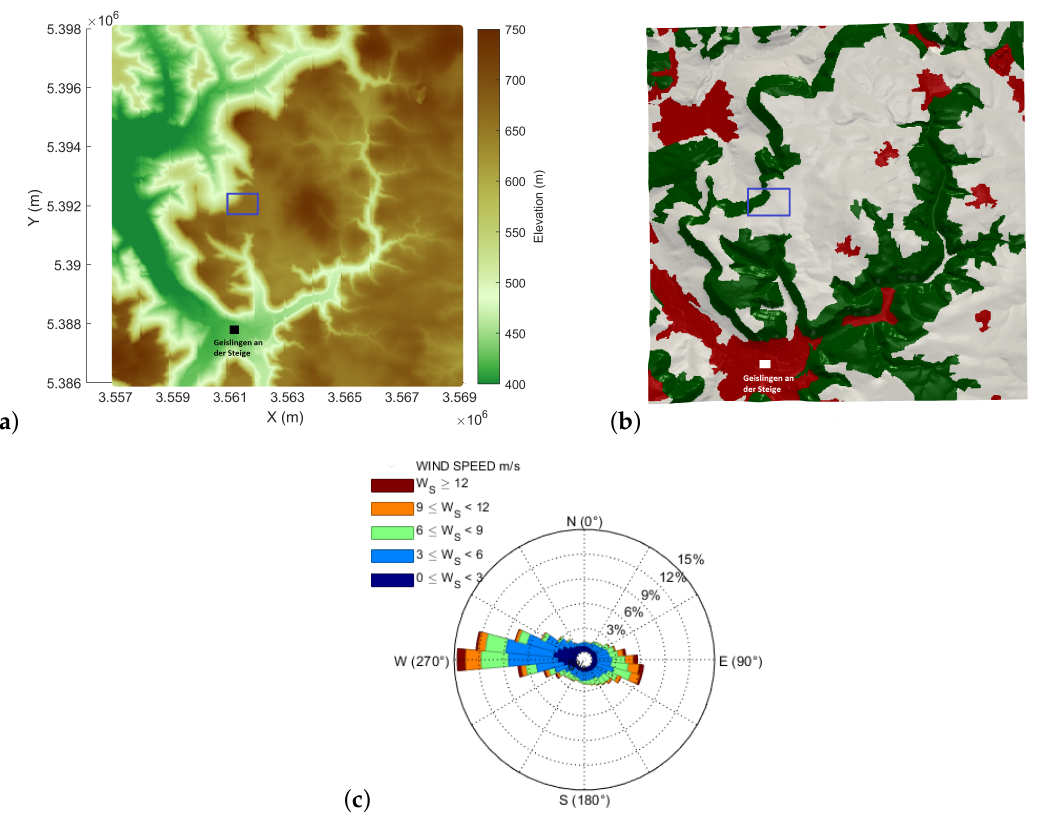
Figure 1. ( a ) Orography with the blue box marking the test-site (Gauß-Krüger coordinates); ( b ) the different land uses applied in the simulations: red for urban, grey for ground and green for forest; ( c ) wind rose from 86 m at the test-site tower for the period of mid